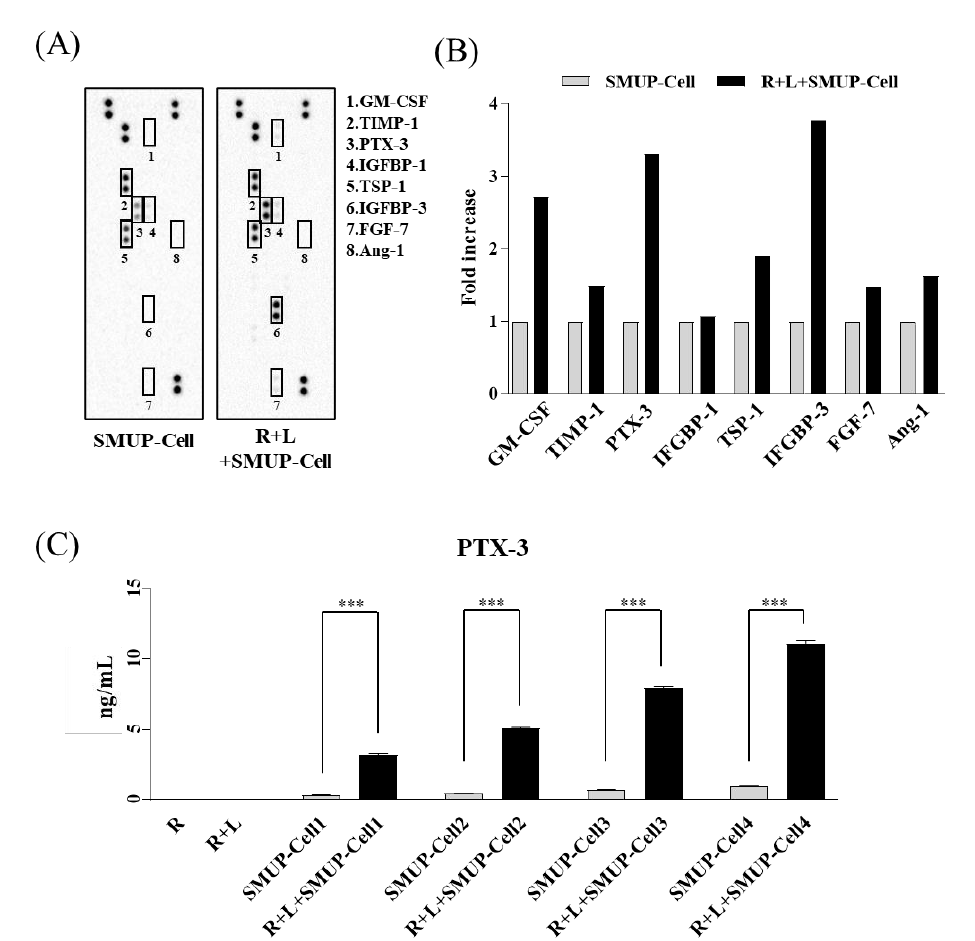
Figure 4. Array to evaluate the changes in SMUP-Cell protein secretion under inflammatory conditions. ( A ) Array analysis using supernatants from SMUP-Cell cultured alone versus SMUP-Cells co-cultured with LPS-exposed Raw 264.7 cells. Secreted proteins were characterized using a protein array (55-spot, n = 1). Eight proteins in the membrane were upregulated in the co-culture group (squares). ( B ) Quantification of optical intensity of anti-inflammatory factors showed upregulated protein secretion in the co-culture relative to that in the culture of SMUP-Cells. Protein levels were evaluated according to fold increase, with data normalized to levels from a culture of SMUP-Cells alone (set to 1). ( C ) To confirm the upregulation of PTX-3, its level was analyzed by ELISA in supernatants from cultures of SMUP-Cells alone and co-cultures in four different lots. Data represent mean ± SD (n = 3 per group). *** p < 0.01. R, Raw 264.7 cells; L, LPS